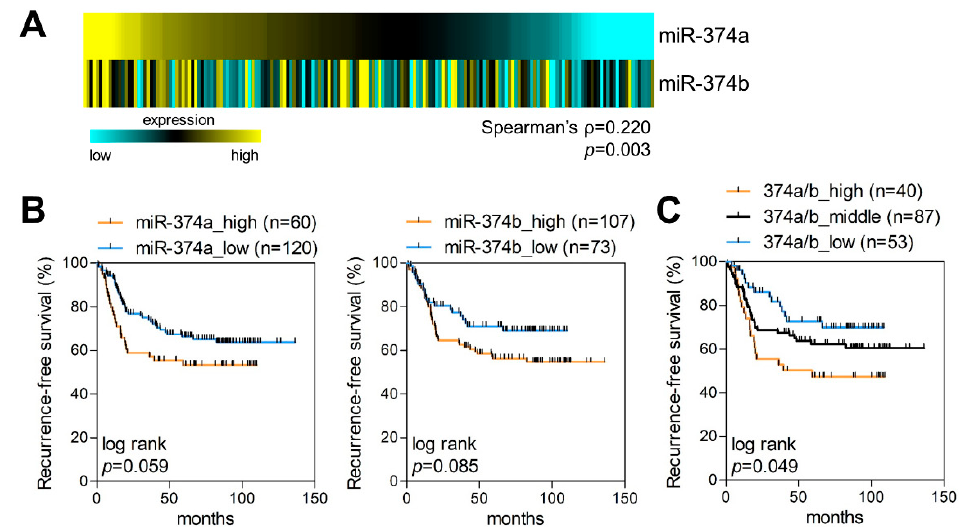
Figure 2. miR-374a and miR-374b are markers of poor prognosis in LUAD patients. ( A ) NanoString analysis of miR-374a and miR-374b in LUAD samples. miR-374a- and miR-374b-expression levels were measured in formalin-fixed paraffin-embedded (FFPE) tumors from LUAD patients ( n = 180). ( B ) Recurrence-free survival (RFS) of LUAD patients based on miR-374a and miR-374b expression. LUAD patients were divided into two groups (high and low) based on expression levels of miR-374a (left) or miR-374b (right) obtained from NanoString. ( C ) RFS of LUAD patients based on miR-374a and miR-374b expression. LUAD patients were divided into three groups: 374a / b_high, high expression of both miR-374a and miR-374b; 374a / b_middle, low expression of one; and 374a / b_low, low expression of both miR-374a and miR-374b according to NanoString.